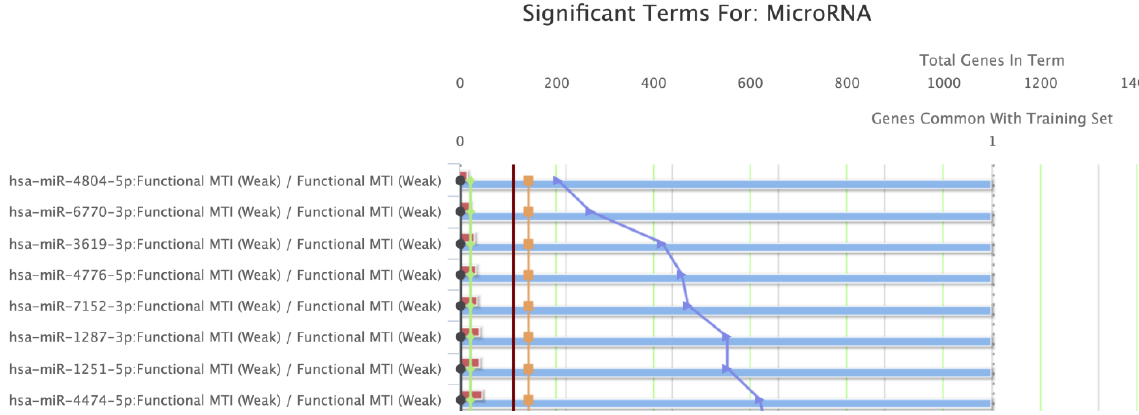
ulators of BCL-xL.